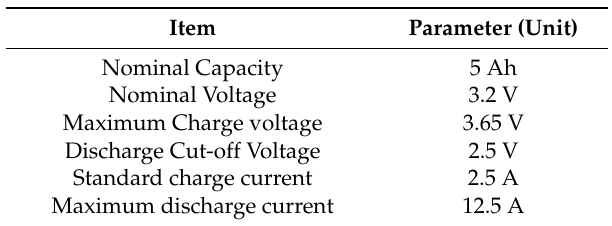
Table 1. Battery